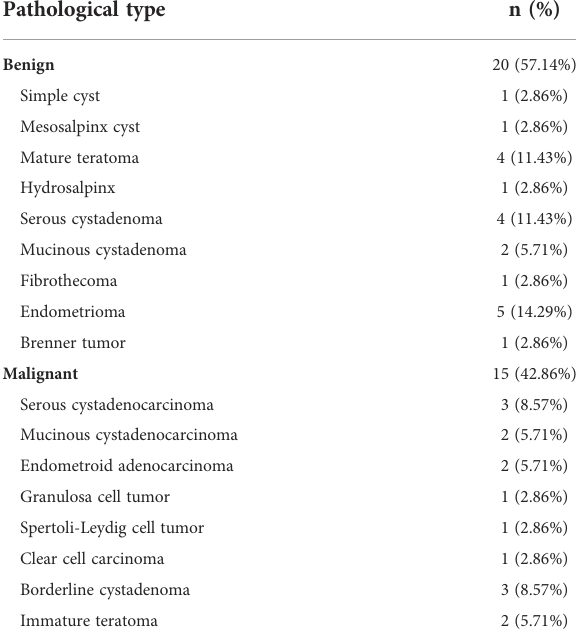
TABLE 1 Pathological types of adnexal masses (n = 35).